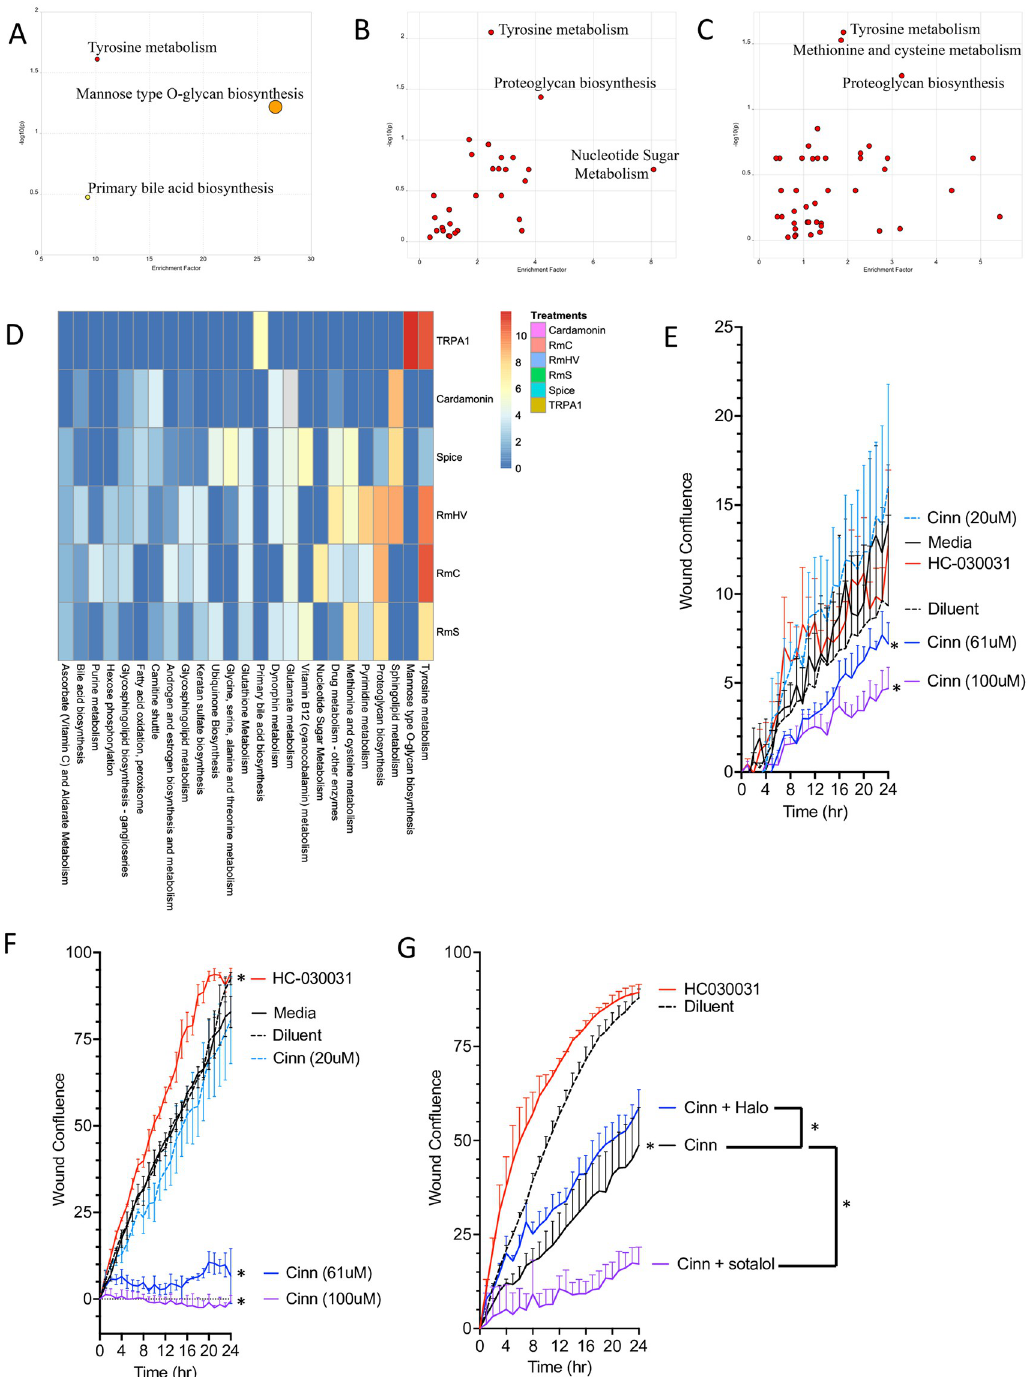
Fig 5. Metabolic influence of TRPA1 is concentrated in tyrosine metabolism. (A-C) Individual pathways as indicated from Metaboanalyst taken from metabolites identified as different between wild type and TRPA1-/- mice in response to TDI (A), R . mucosa treated versus R . mucosa plus Cardamonin (RmC; B), and R . mucosa treated versus R . mucosa plus ground cardamom seeds (RmS; C). (D) Summarizing all pathways impacted by index of pathway significance (IPS) for each condition versus its diluent control. (E, F) Percent of starting wound closure over time for keratinocytes (E) and Schwann neuron cells (F) incubated with diluent, the TRAP1 agonist cinnamaldehyde (Cinn) or TRPA1 blocker HC030031 (N = 1 cells line each in triplicate wells). Significance determined by comparison of area under the curve with 95% confidence intervals by PRISM. (G) Schwann cells in scratch assay with Cinn with or without addition of anti-dopaminergic haloperidol (halo) or anti-adrenergic sotalol (N = 1